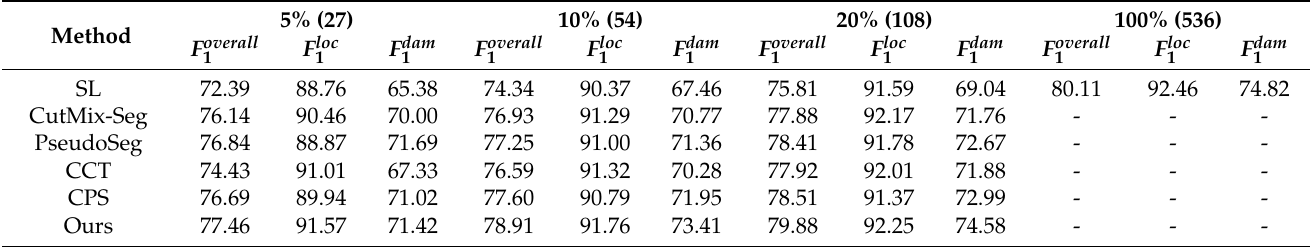
Table 4. Quantitative comparison of different SSL methods on the Moore dataset (%).